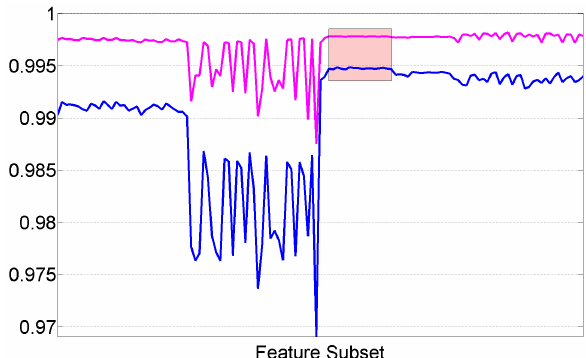
Figure 3: Average F-Scores (blue) and areas under ROC curve (magenta) for all feature subsets. The best range is highlighted by a box.